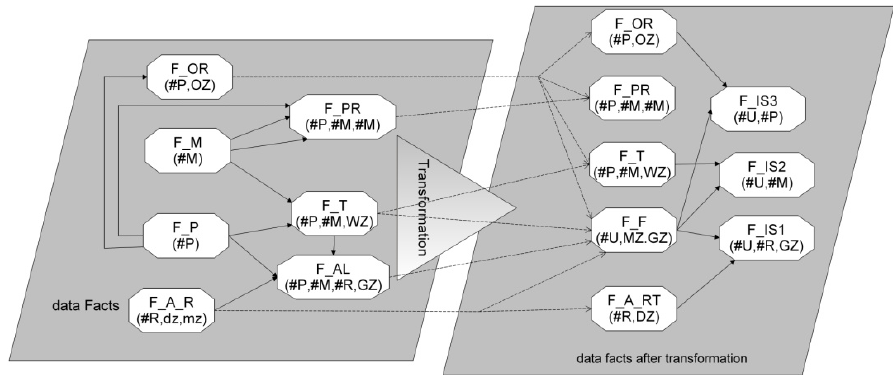
Fig. 3. The schema of transformation of the facts for illustrative